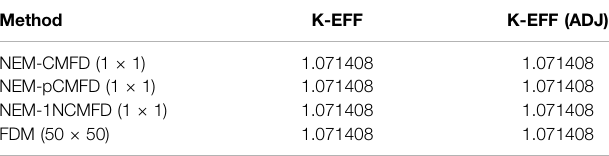
TABLE 3 | Calculated multiplication factors for the one-group reactor problem.